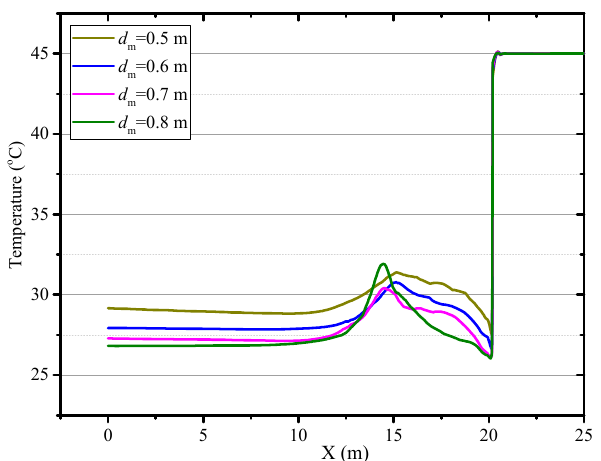
Figure 9. Air temperature distribution in Z = 0.5 m plane under different diameter of air duct.